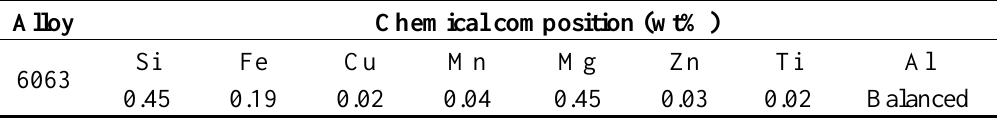
Table 1. Chemical composition* of commercial billet used in the study. Alloy Chemical composition (wt%)